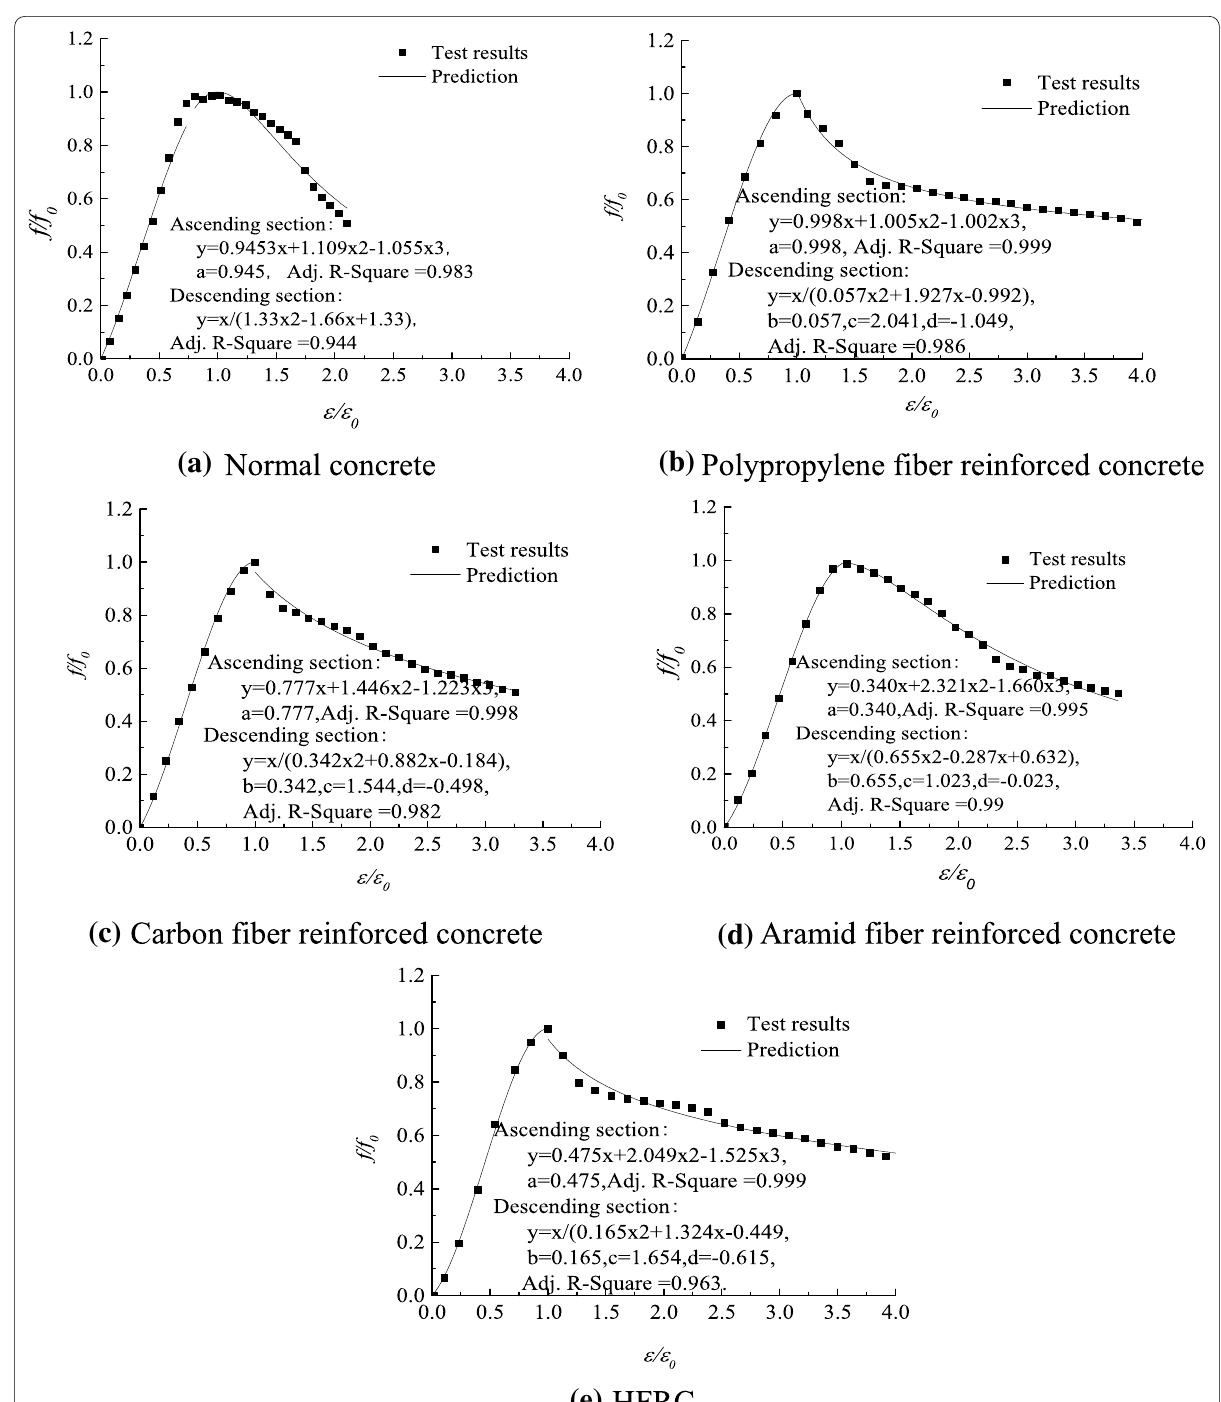
Fig.11 Comparison of experimental results and predictions. The test datum of each point is derived from the average of three replicates. a Normal concrete. b Polypropylene fiber reinforced concrete. c Carbon fiber reinforced concrete. d Aramid fiber reinforced concrete. e